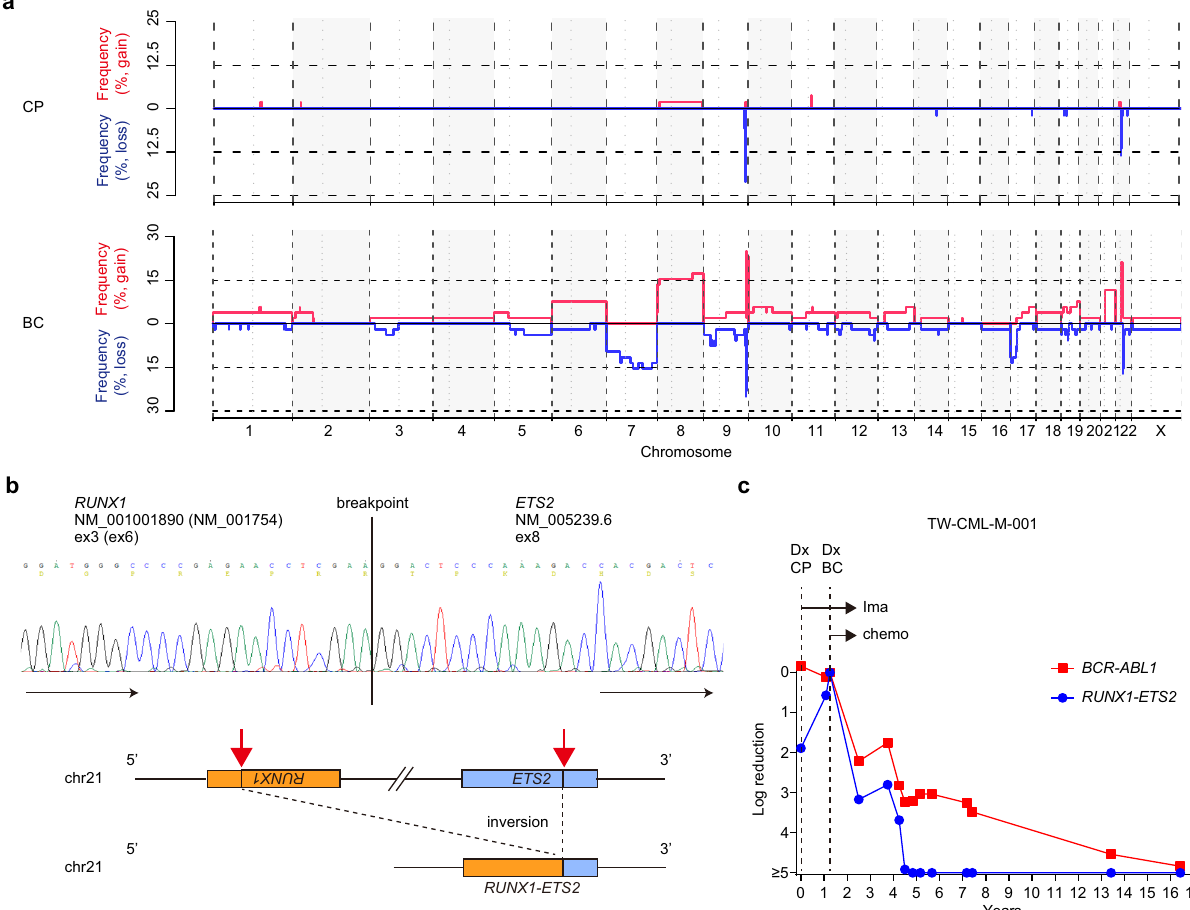
Fig. 2 CNAs and RUNX1 - ETS2 fusion in CML-CP and BC. a Sequencing-based copy-number pro fi ling in CML-CP and BC samples from 52